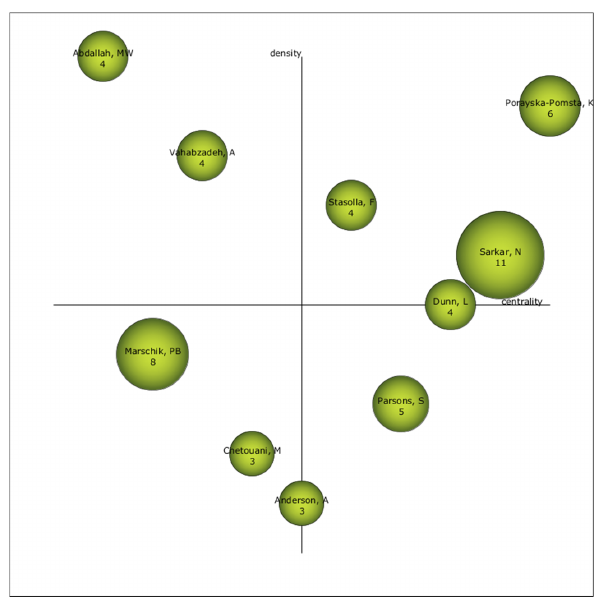
Figure 6. Strategic author diagram of the entire production.